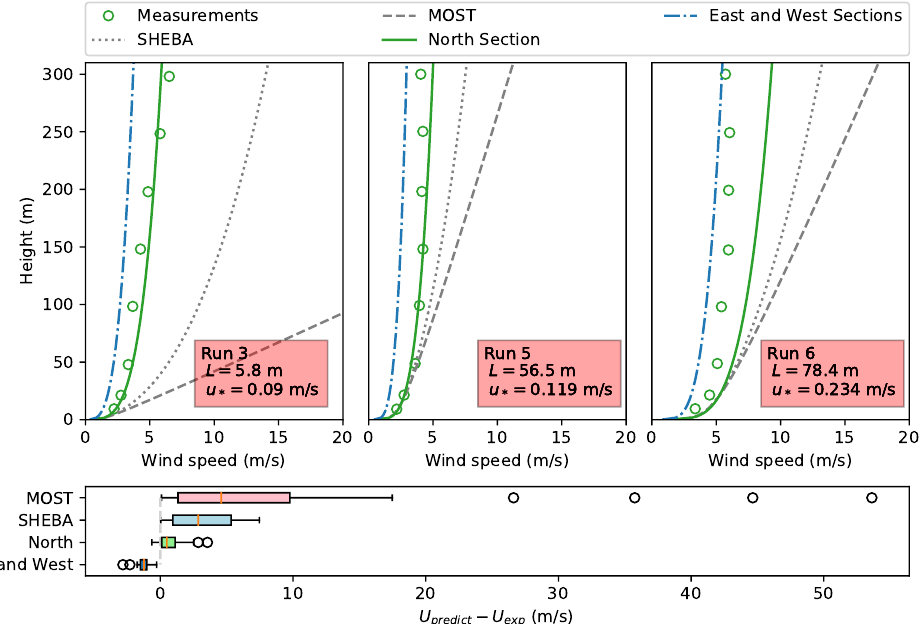
Figure 7. Velocity profiles estimated based on different similarity functions φ m ( ζ ) (the upper part) and boxplots of errors of velocity predictions (the lower part). U exp is the measured velocity in runs 3, 5, and 6, whereas U predict is the value predicted at the corresponding height.